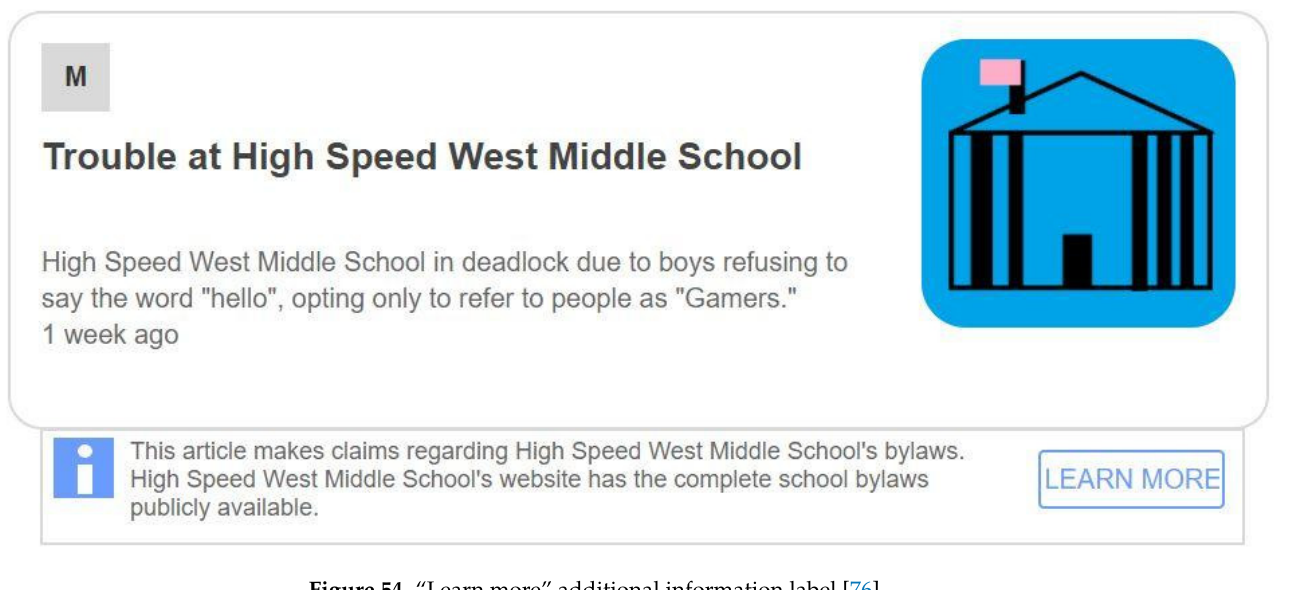
Figure 54. “Learn more” additional information label [76].